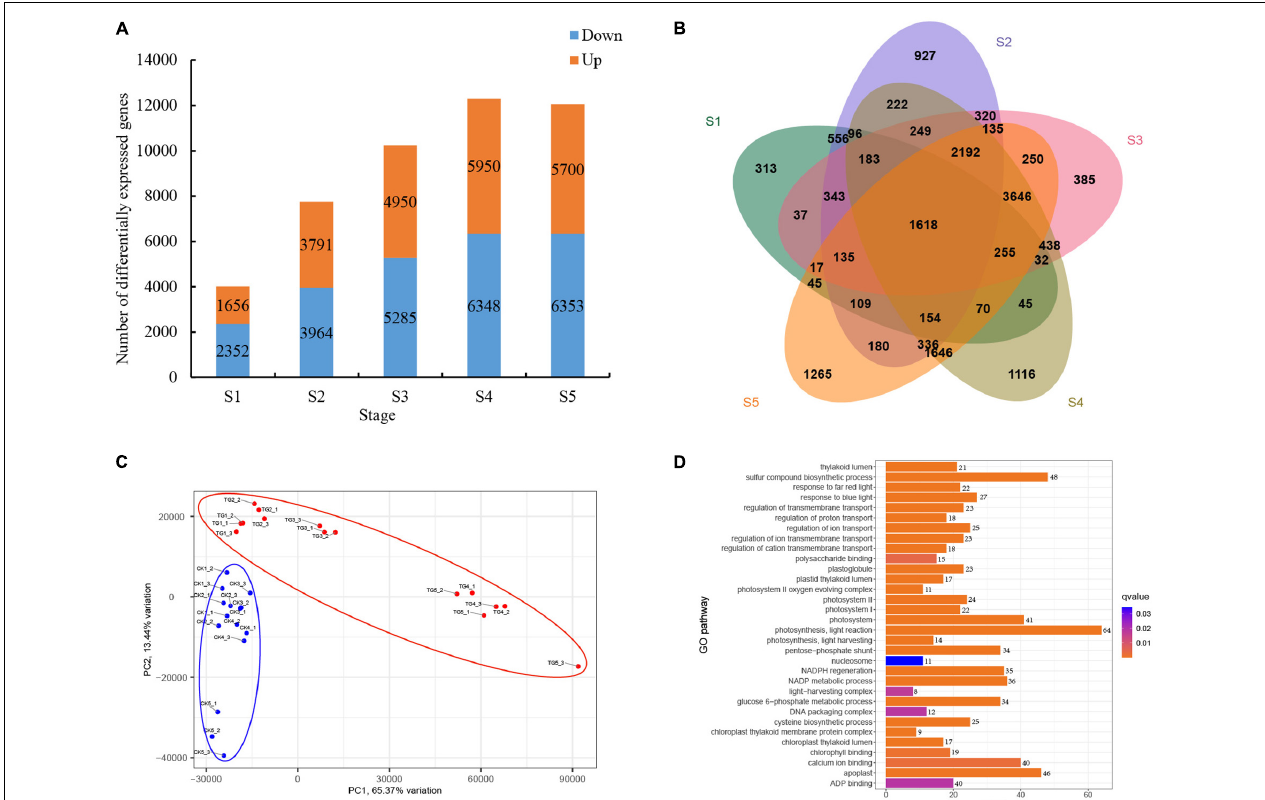
FIGURE 6 | Analysis of differential gene expression in foxtail millet at different stages. (A) DEGs at different stages; (B) venn analysis of DEGs at different stages; (C) PCA analysis of samples; (D) GO enrichment analysis of common DEGs.